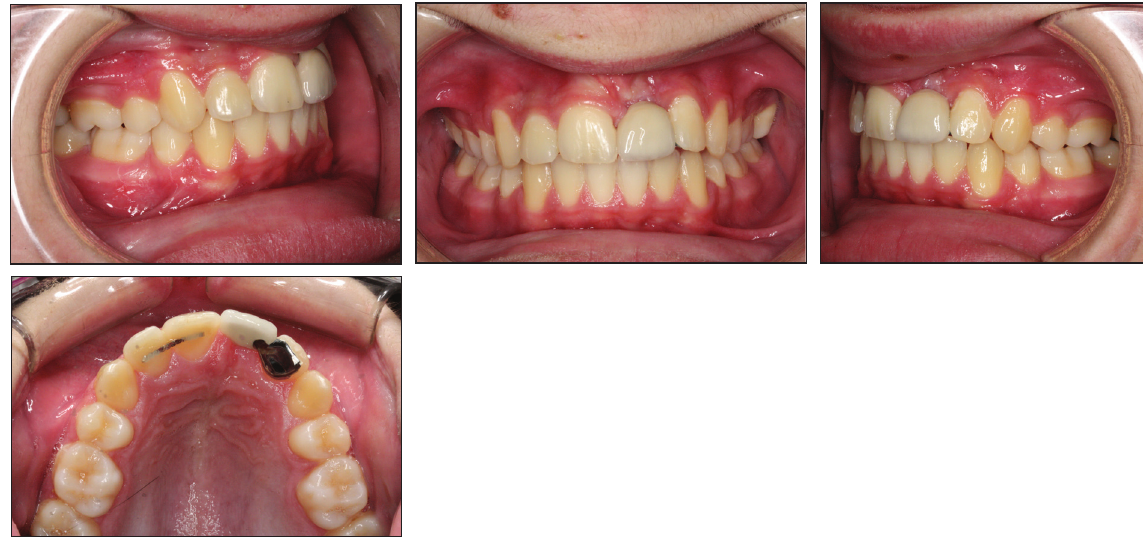
Figure 12. Post-treatment intra-oral photographs. Note RRB in situ, cantilevered from the palatal surface of upper left permanent lateral